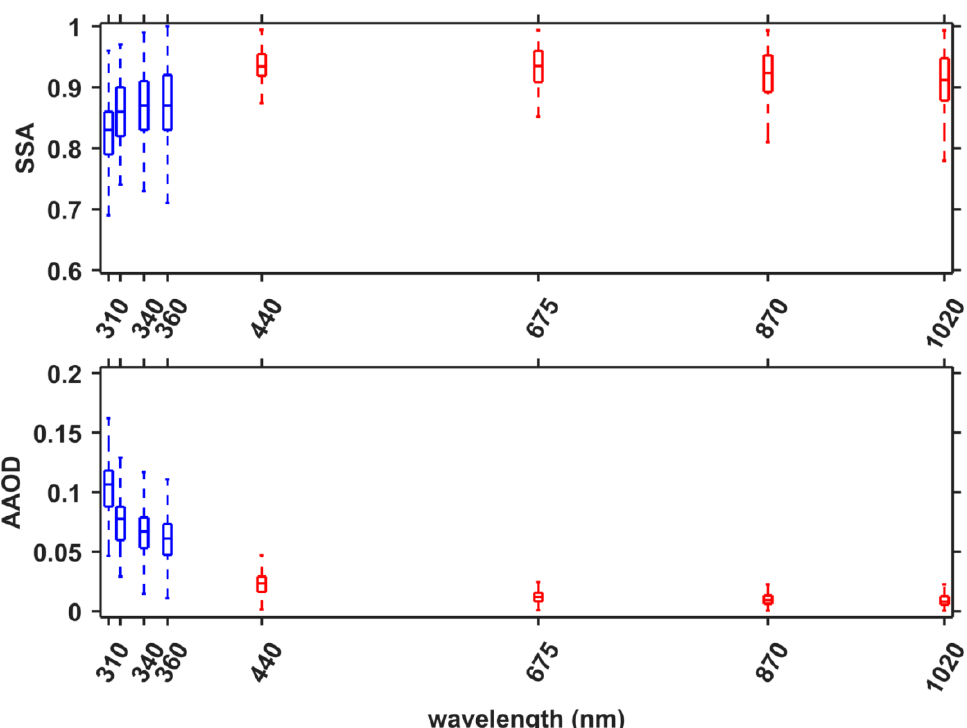
Figure 2. Spectral dependence of the SSA (upper panel) and AAOD (lower panel). Data from Brewer#086 are shown in blue, while data from CIMEL are shown in red. On each box, the central mark indicates the median, and the bottom and top edges of the box indicate the 25th and 75th percentiles (inter-quartile range, IQR), respectively. The whiskers are stretched to the maximum and minimum within 1.5 times the IQR, and for a normal distribution represent ~99.3% of the data points.